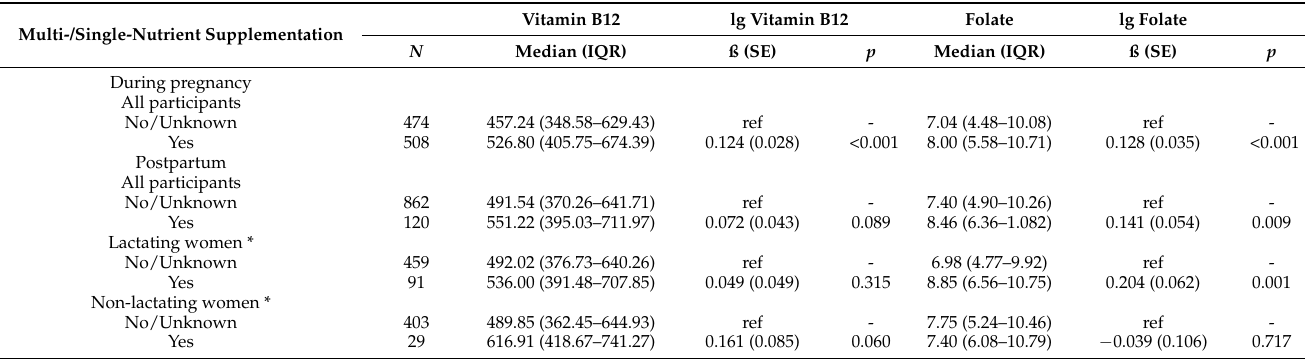
Table 3. The adjusted association of multi-/single-nutrient supplementation with vitamin B12 and folate levels by multiple linear regression model.